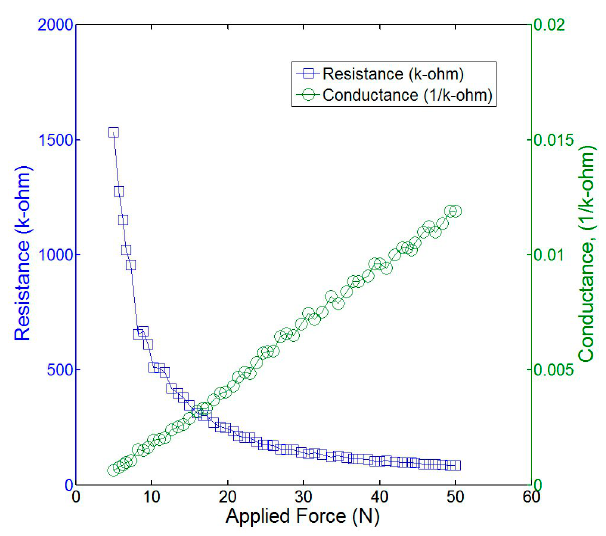
Figure 10. The electrical resistance and conductance of the sensor corresponding to an applied force.